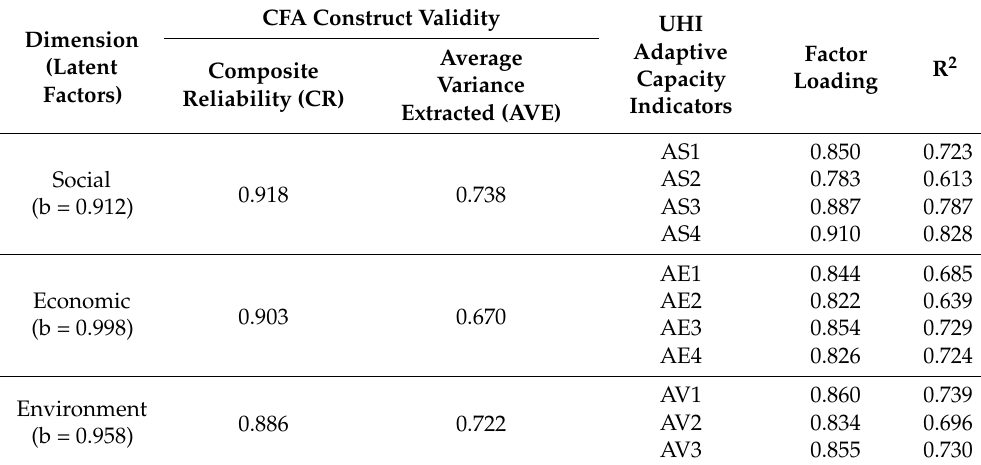
Table 8. First- and second-order CFA of UHI adaptive capacity indicators.